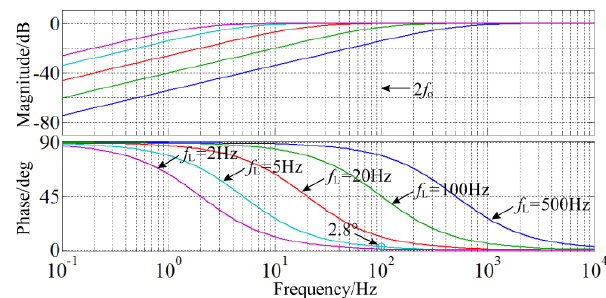
Figure 3. Bode diagram of 1/ G PI ( s ) with different f L .